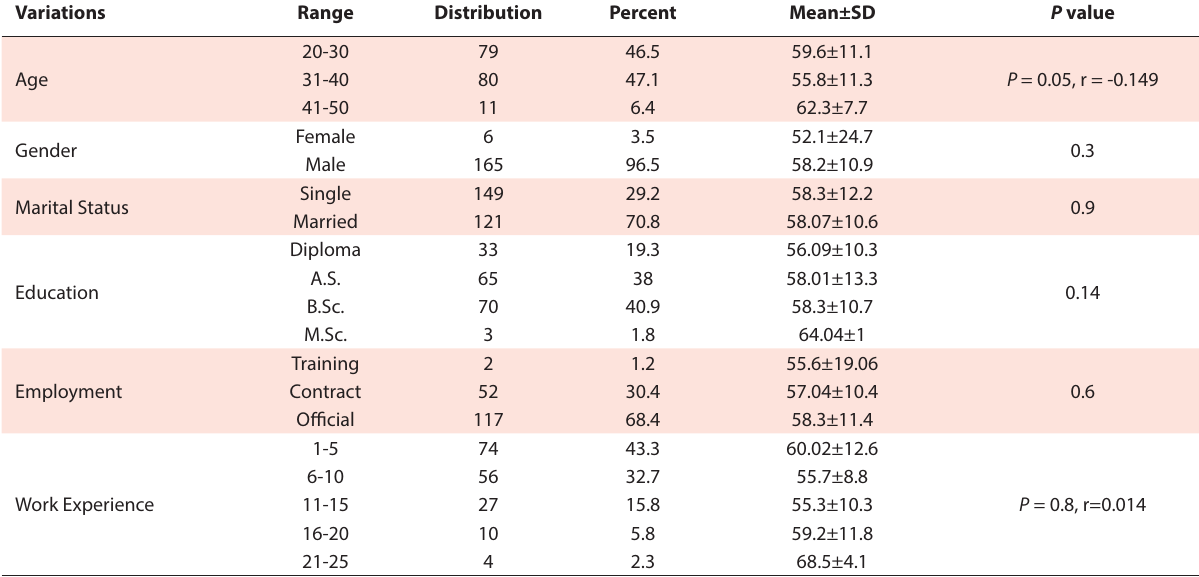
Table 1. Relative and absolute frequency table along with the average of the ability to take medical history of patients in medical emergency in Golestan Province EMS according to demographic features in 2015